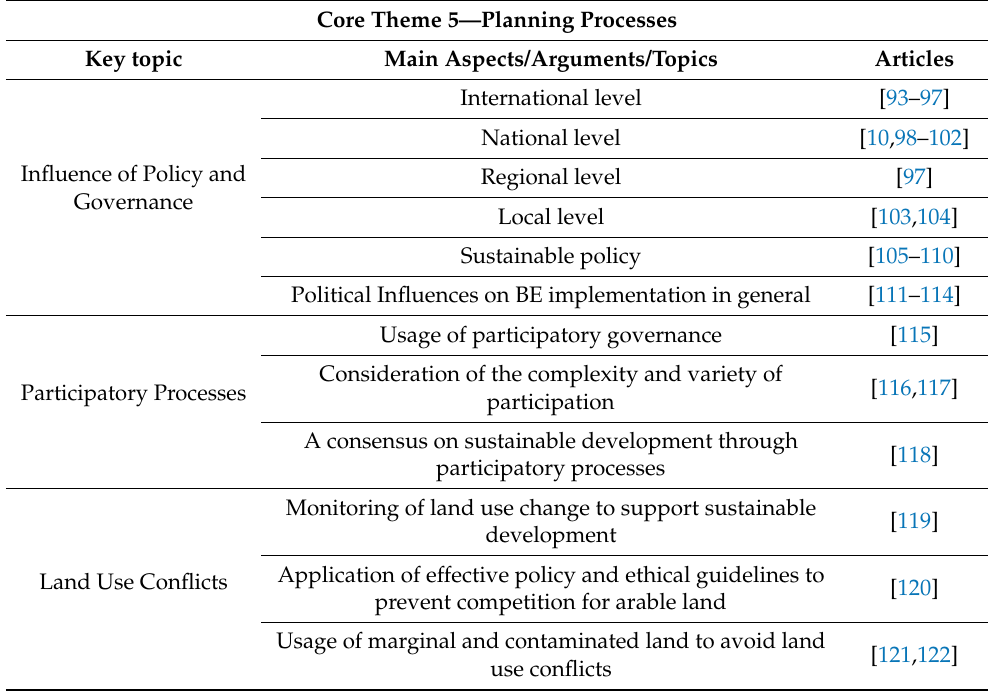
Table 5. Key topics and main aspects/arguments referring to Core Theme